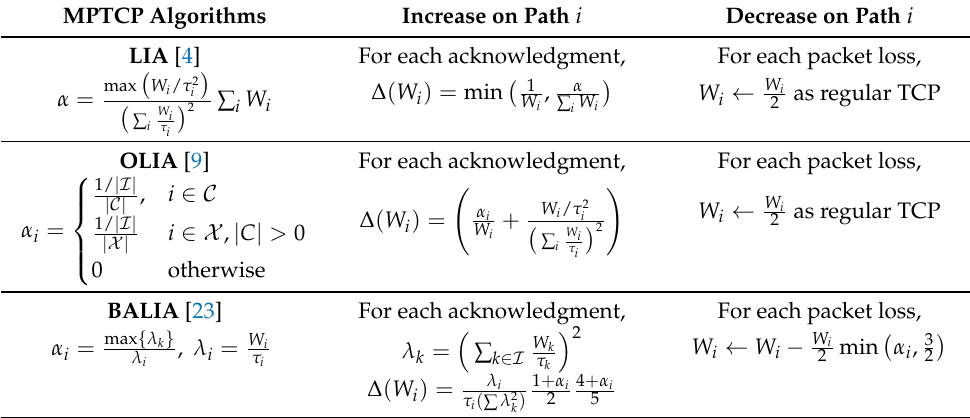
Table 1. Summary of MPTCP congestion control for LIA, OLIA, and